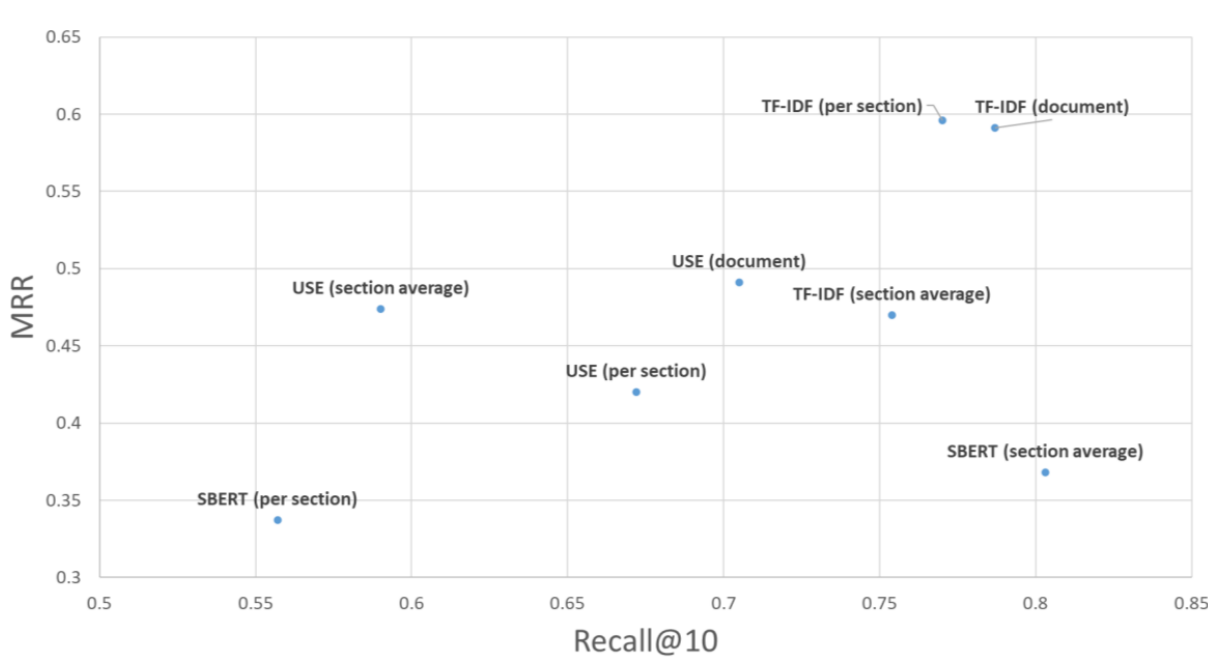
Figure 8. Scatter plots of the results for the eight patterns using the proposed approach.